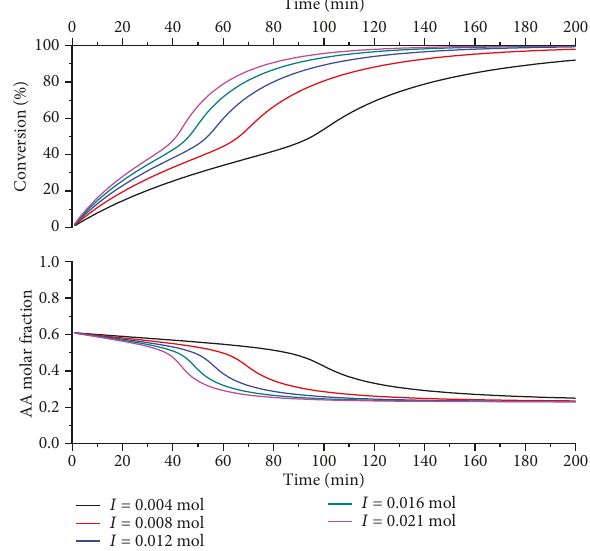
Figure 6: E ff ect of the initiator amount on the conversion and composition pro fi les. M = 0 054 , r r 11 = 1 0 s 2